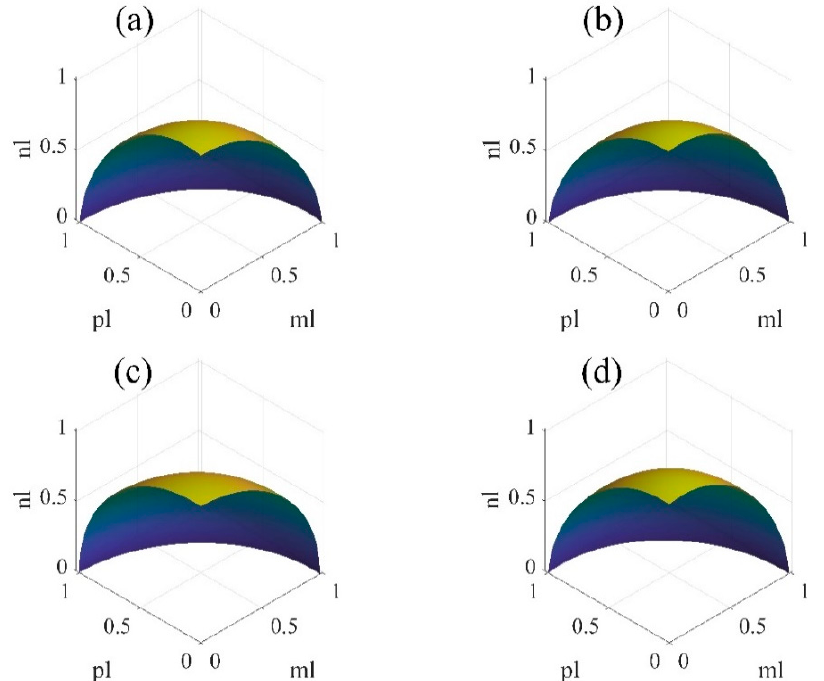
Figure 9. The limit state surfaces of straight pipes with local wall-thinning defects under the combination of internal pressure, bending moment, and torque: ( a ) axial defect; ( b ) circumferential defect; ( c ) large-area defect; ( d ) small-area defect.